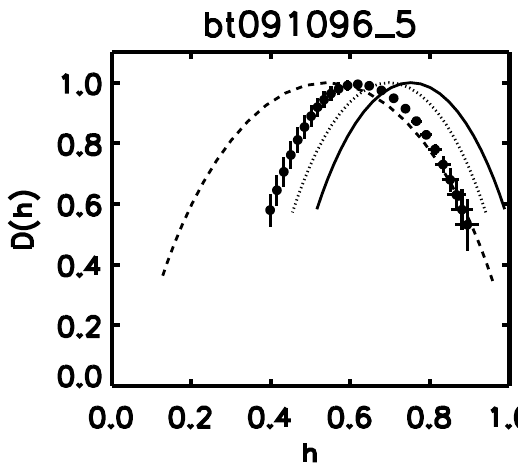
Fig. 7. Comparison of D(h) singularity spectra obtained by Leg- endre transforming experimental τ(q) shown in Fig. 4 (dots with error bars) and intermittency models: Kraichnan-like (continuous line), Kolmogorov-like (dotted line), and p -model (dashed line).